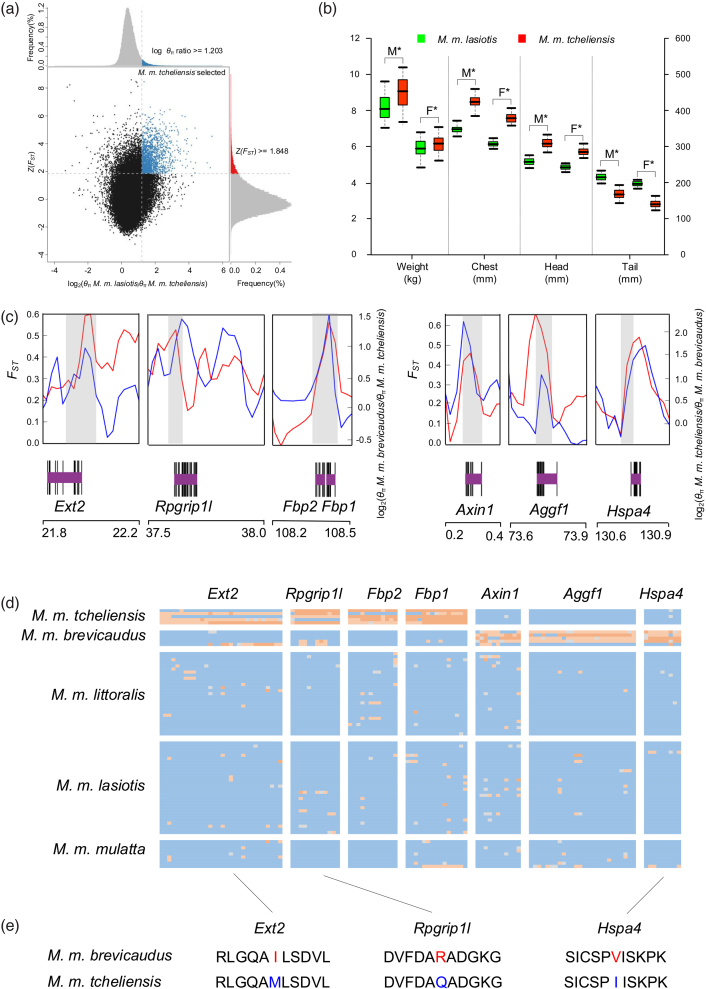
Genomic regions with selection-sweep signals in RM. (a) Distribution of log2 (θπM. m. lasiotis/θπM. m. tcheliensis) and Z (FST) of 50-kb windows with 25-kb steps. Blue dots located in the selected regions requirement (corresponding to Z test P< 0.05, where Z (FST) ≥ 1.848 and θπ log-ratio ≥ 1.203) represent selected windows for M. m. tcheliensis. (b) Morphological comparison between M. m. tcheliensis and M. m. lasiotis. M and F represent males and females. (c) Example of genes with selection sweep signals. Ext2, Rpgrip1l, Fbp2, and Fbp1 in M. m. tcheliensis and Axin1, Aggf1, and Hspa4 in M. m. brevicaudus. FST and θπ log-ratios between the two subspecies are represented in red and blue, respectively. All values in Fig. 3c are plotted using 50-kb windows with half steps. Genome annotations are show at the bottom (black bar, coding sequences (purple bar, genes). (d) SNP genotypes in putative selective sweeps containing Ext2, Rpgrip1l, Fbp2, Fbp1, Axin1, Aggf1, and Hspa4. (e) Nonsynonymous variants in gene Ext2, Rpgrip1l and Hspa4.